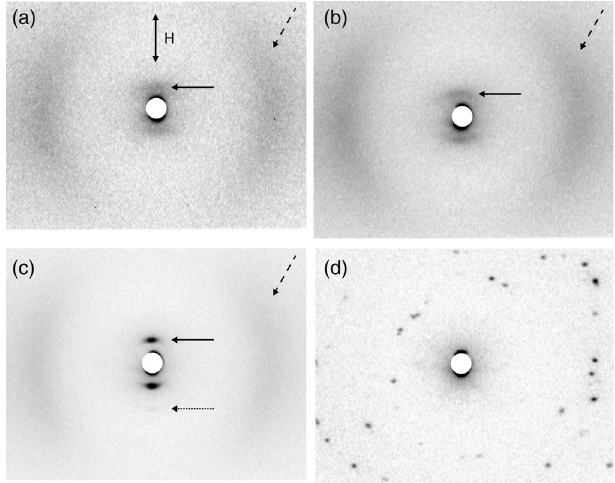
FIG. 15. X-ray scattering patterns of a BP12 sample aligned by a 1.7 T magnetic field H [double-headed arrow in (a)] recorded with a 60 mm sample-to-detection distance. (a) In the N phase ( T ¼ 117 °C); (b) in the N phase ( T ¼ 107 °C); (c) in the M X TB phase ( T ¼ 97 °C); and (d) in the crystalline phase (room temperature). White disks at the pattern centers represent the beam stop. In (a) – (c), the dashed arrow points to the wide-angle diffuse ring. In (a) and (b), the solid arrow points to small-angle diffuse streaks. In (c), the solid arrow points to one of the two first-order smectic reflections, while the dotted arrow points to one of the two second-order smectic reflections. In (d), the pattern shows only sharp Bragg reflections arising from several large crystallites in reflection position in the x-ray